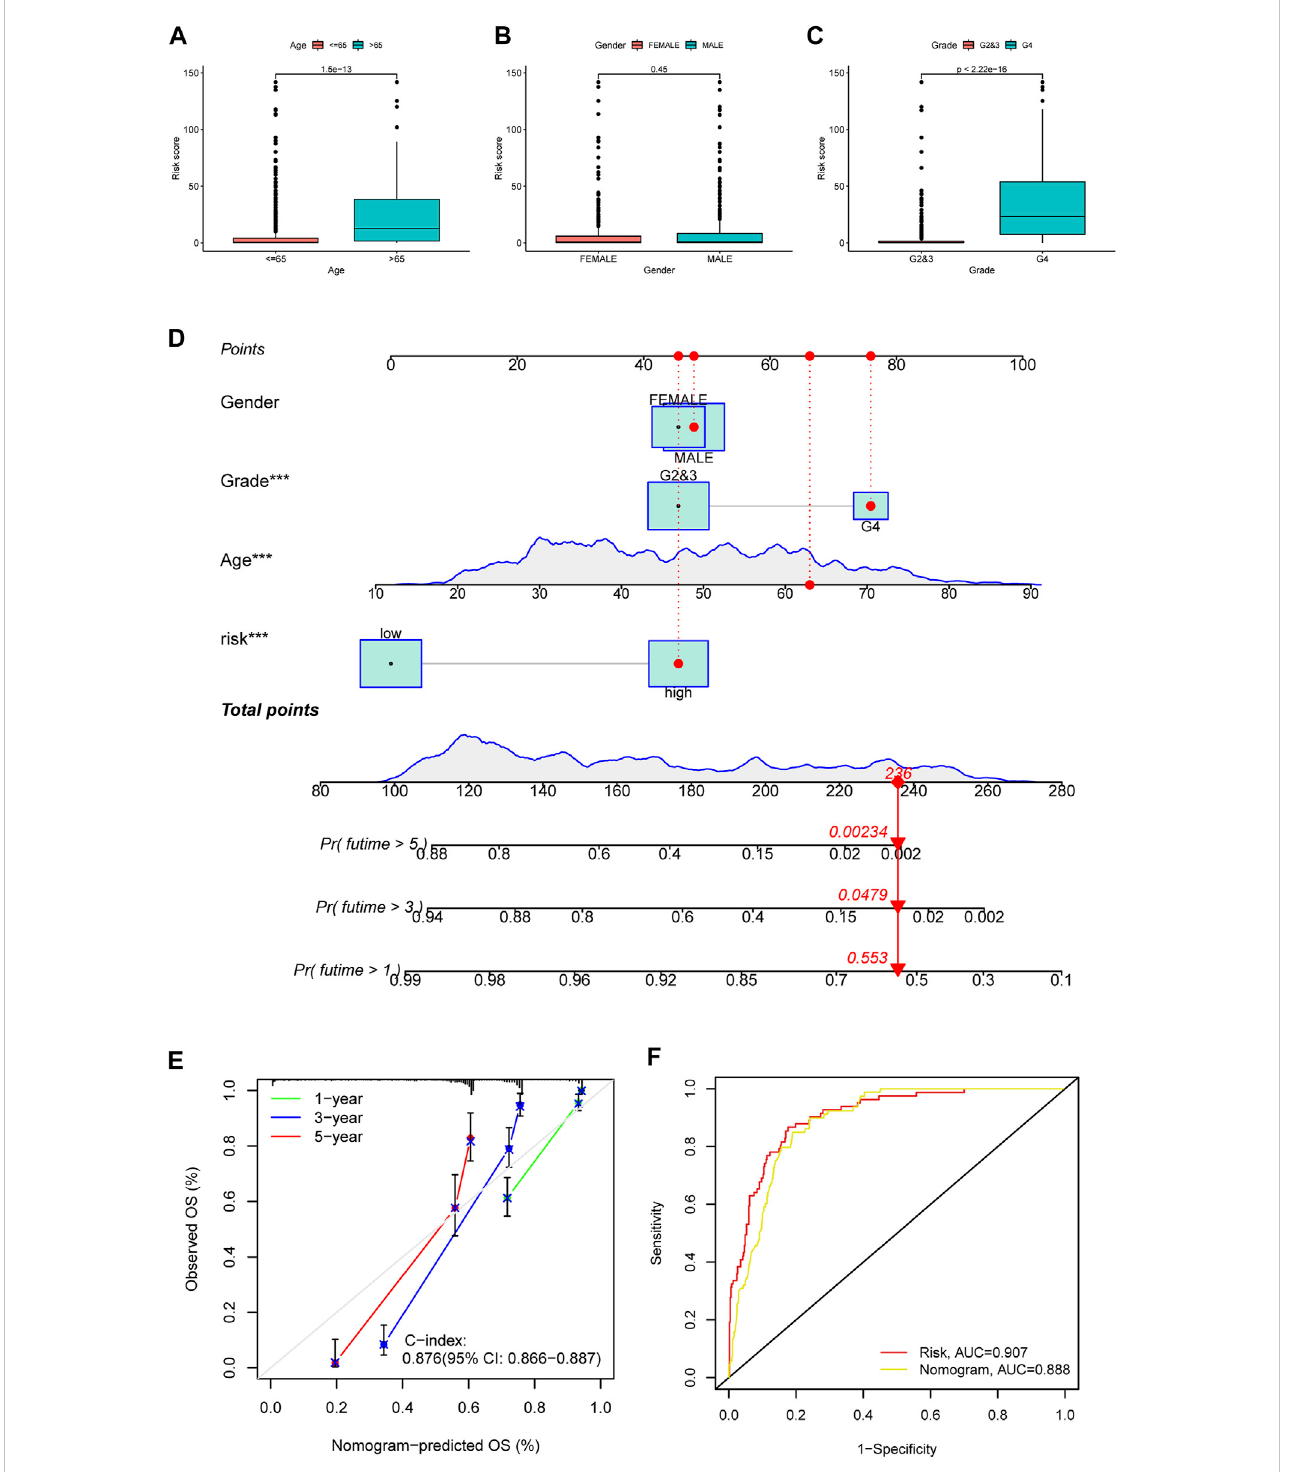
FIGURE 2 Clinicalrelevanceofriskscore,andconstructionandevaluationofnomogram.Theriskscorevariationbetweenpatientsofdifferentages (A) ,genders (B) andtumorgrades (C) wereshowninboxplots. (D) Anomogramtopredictthe1-,3-,and5 yearsurvivalpossibilityofgliomapatients.Thebluelinesofageand total points showed the distribution of the corresponding continuous variables in the data set used to establish the model. The points for each attribute